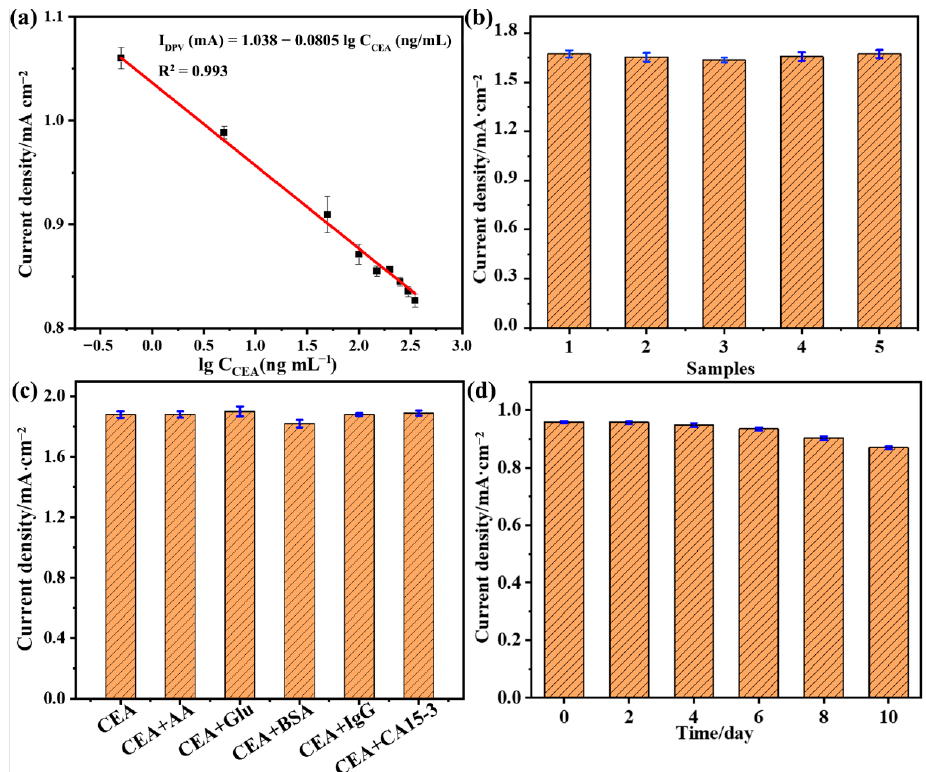
Figure 5. ( a ) Calibration plots of the electrochemical immunosensor for CEA detection. ( b ) Current response of five immunosensors to 100 ng/mL CEA. ( c ) Current response of the immunosensor to pure CEA and CEA mixed with 100 ng/mL of other interference substances. ( d ) The current density response to 5 ng/mL CEA after different durations.